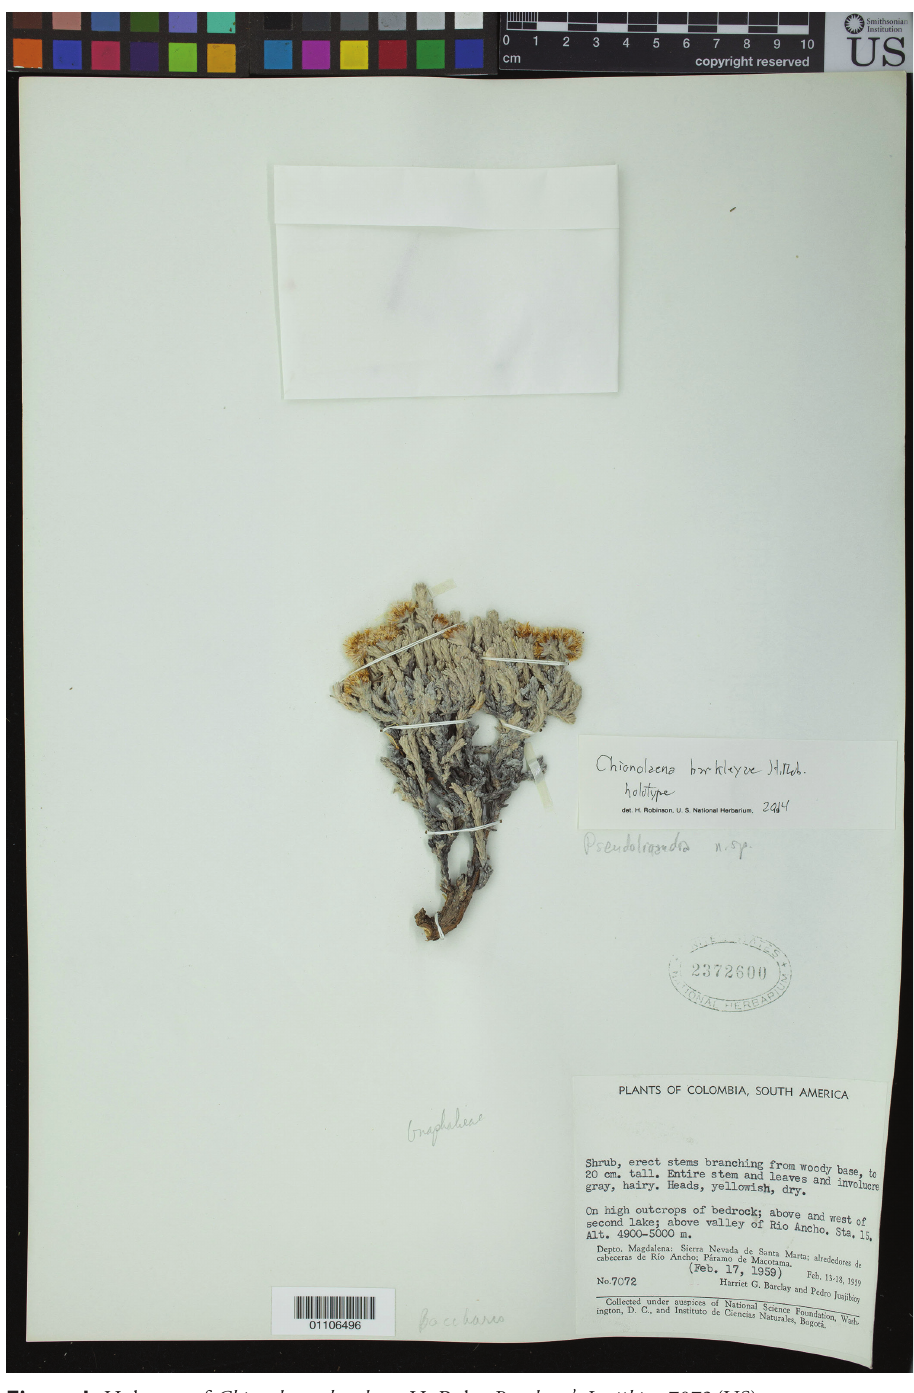
Figure 1. Holotype of Chionolaena barclayae H. Rob., Barxlay & Juajibioy 7072